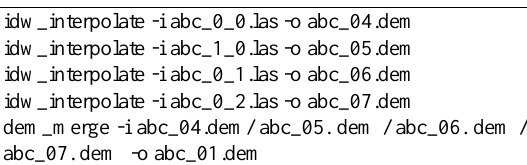
Table1. A list of automatically generated task scripts